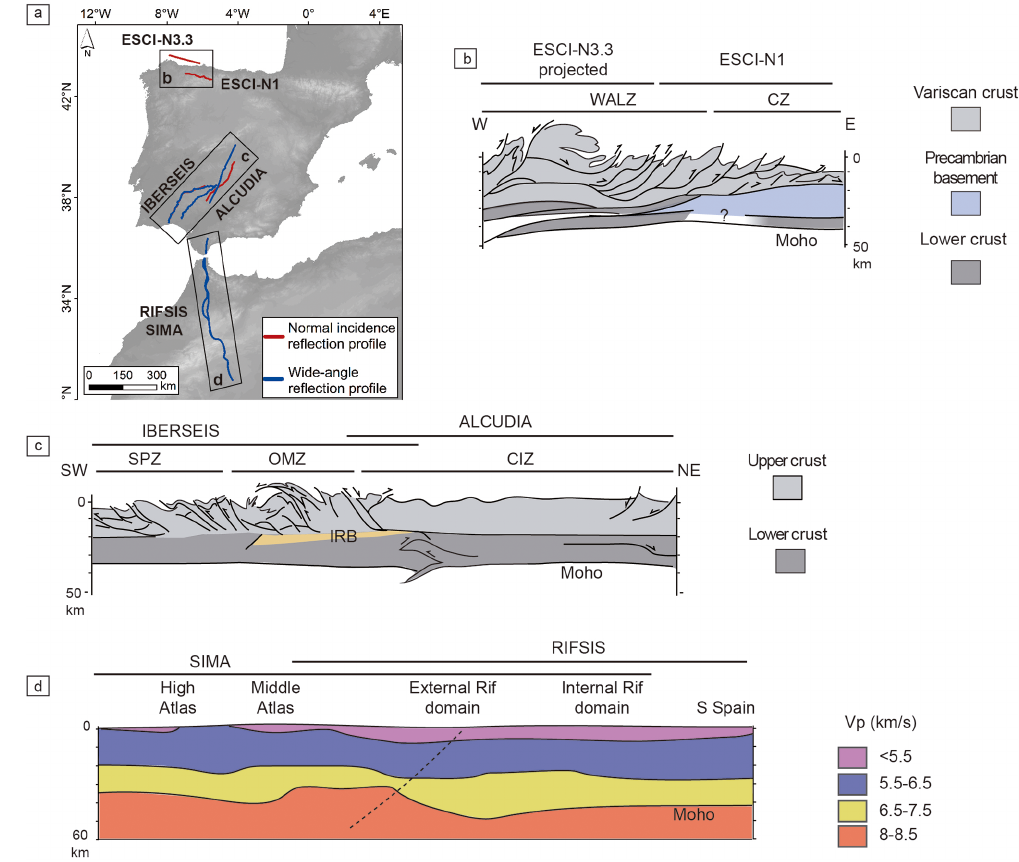
Figure 4. (a) Map of the Iberian Peninsula and north of Africa with the location of the ESCI-N, IBERSEIS, ALCUDIA, RIFSIS, and SIMA projects. The topography is from OpenTopography (Ryan et al., 2009); (c) crustal structure of the southern Iberian Massif (SPZ: South Portuguese Zone; OMZ: Ossa Morena Zone; and CIZ: Central Iberian Zone; IRB: Iberian Reflective Body) revealed by the IBERSEIS and ALCUDIA projects (after Simancas et al., 2013; Ehsan et al., 2015; Palomeras et al., 2009); (b) crustal structure of the northern Iberian Massif revealed by the ESCI-N1 and N3.3 profiles (WALZ: West Asturian-Leonese Zone; CZ: Cantabrian Zone) (after Ayarza et al., 1998; Pérez-Estaún et al., 1997; Simancas et al., 2013); and (d) P-wave velocity model obtained from the wide-angle reflection data of RIFSIS and SIMA (simplified from Ayarza et al., 2014; Gil et al.,